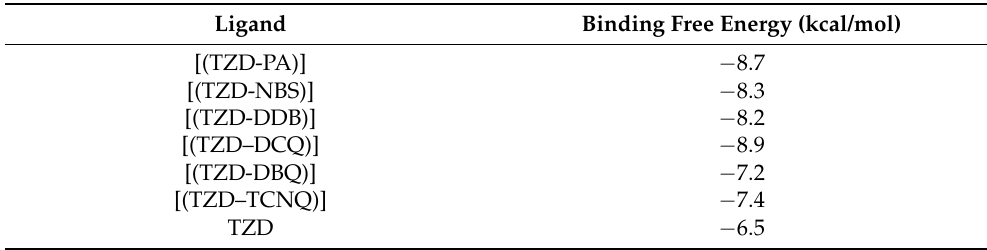
Table 1. The docking score of TZD alone and TZD with the six synthesized CT complexes against serotonin (PDB ID: 6BQH).